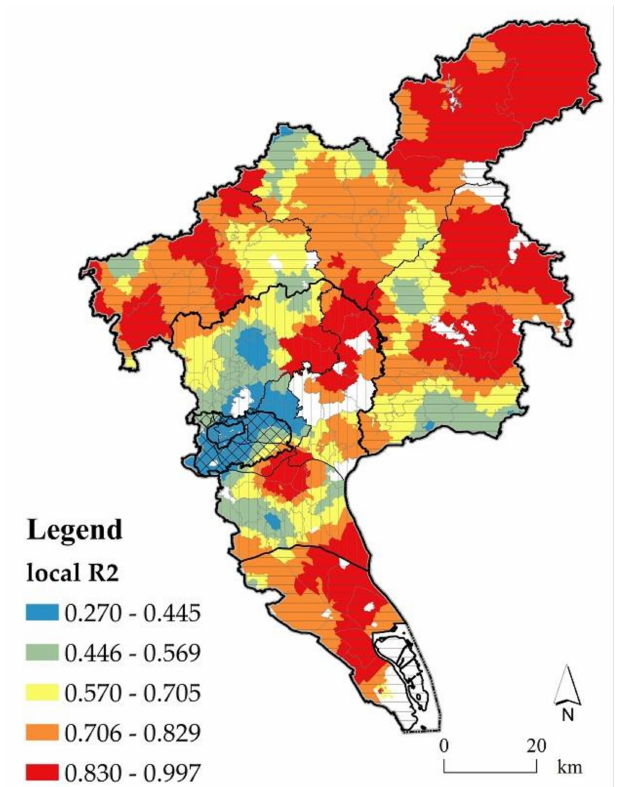
Figure 5. Spatial distribution of local R 2 in the GWR model.